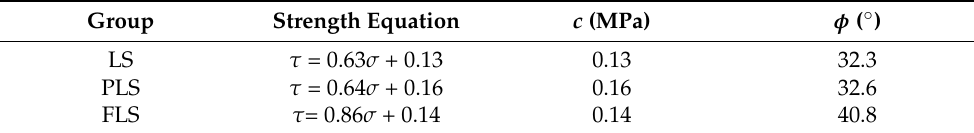
Table 5. Strength parameters. Group